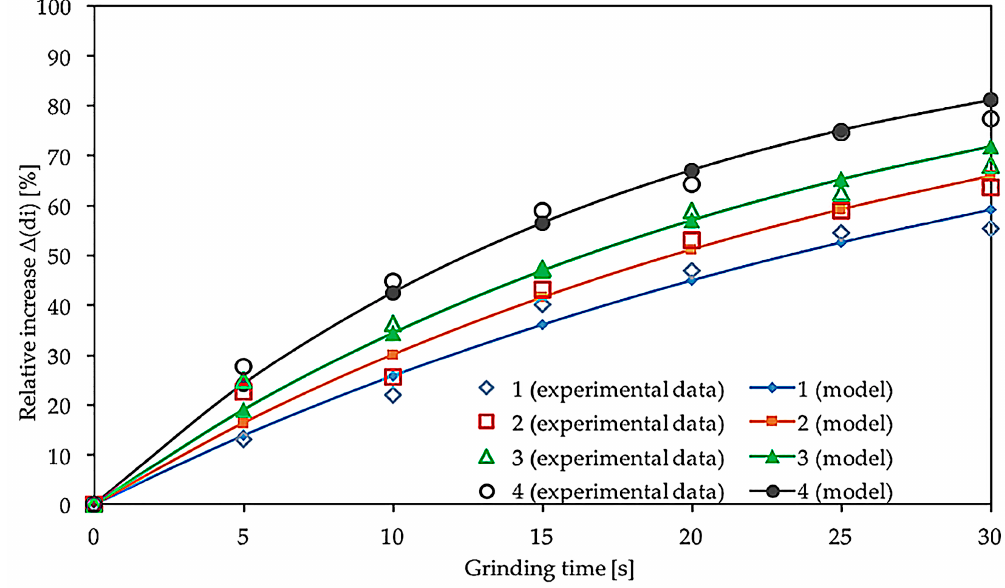
Figure 3. The curves of the relative increment of the 0–0.02 mm particle size fraction in the comminution product for the investigated grinding media characteristics.